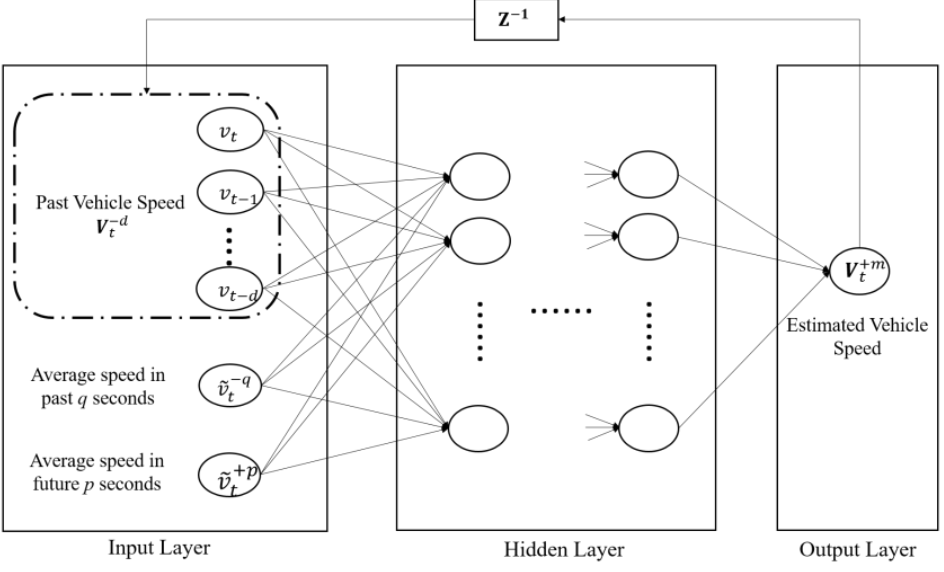
Figure 17. NARX architecture used to predict future speed. In this paper, the Matlab Neural Network tool-box is used to train the NARX network. The hidden layer has a size of 5, and the feedback delay ( d ) is 5. Meanwhile, the